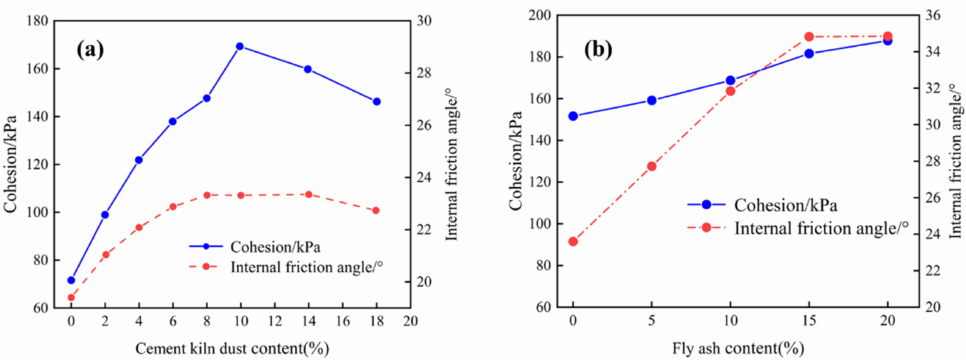
Figure 6. Evolution of internal friction angle and cohesion of expansive soil: ( a ) stabilized soil by cement kiln ash, and ( b ) stabilized soil by fly ash. Adapted from [69,71].